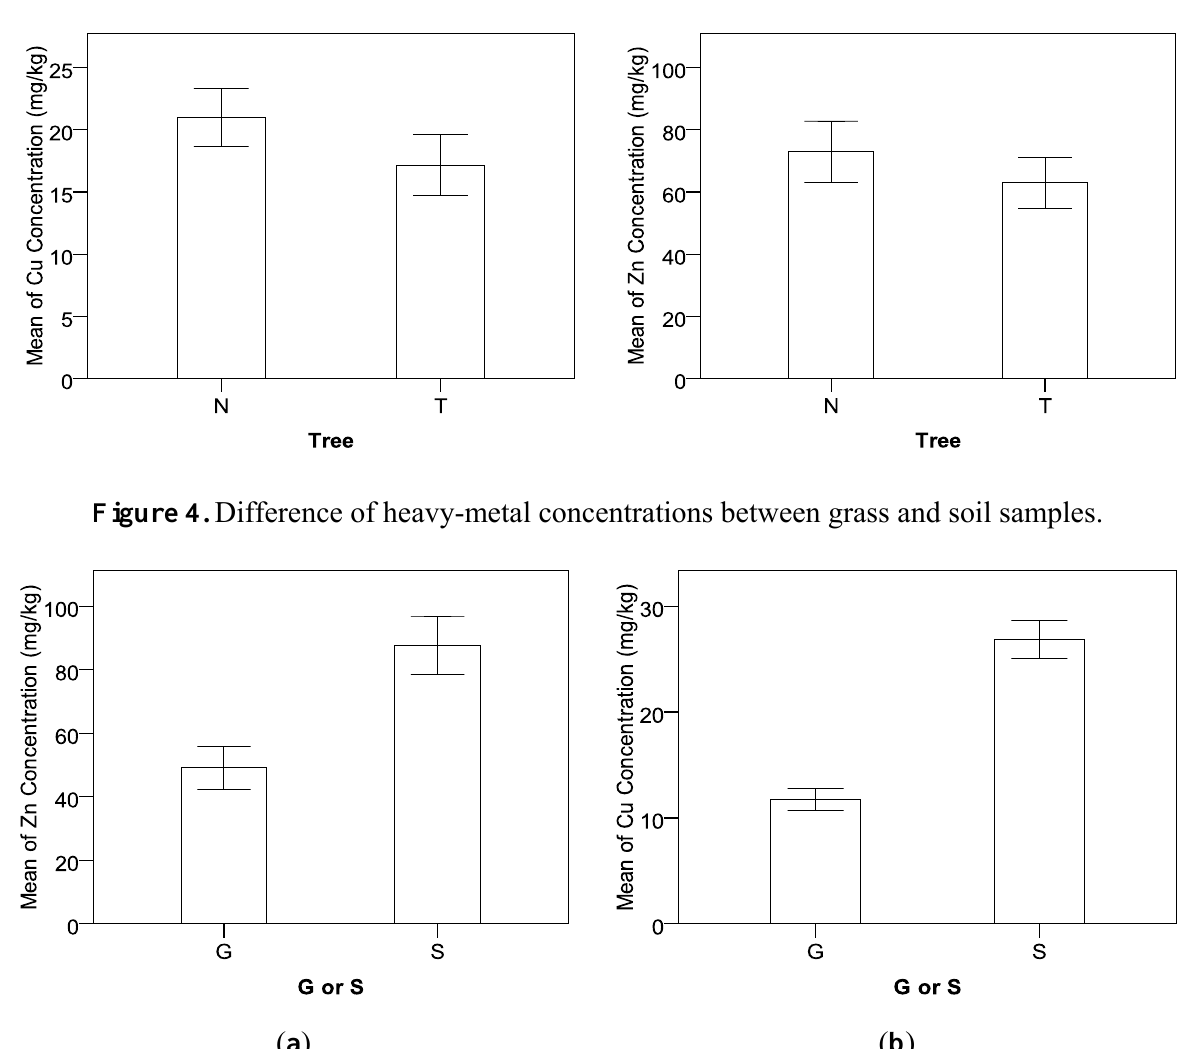
Figure 3. Effects of tree protection on concentrations of Cu and Zn.